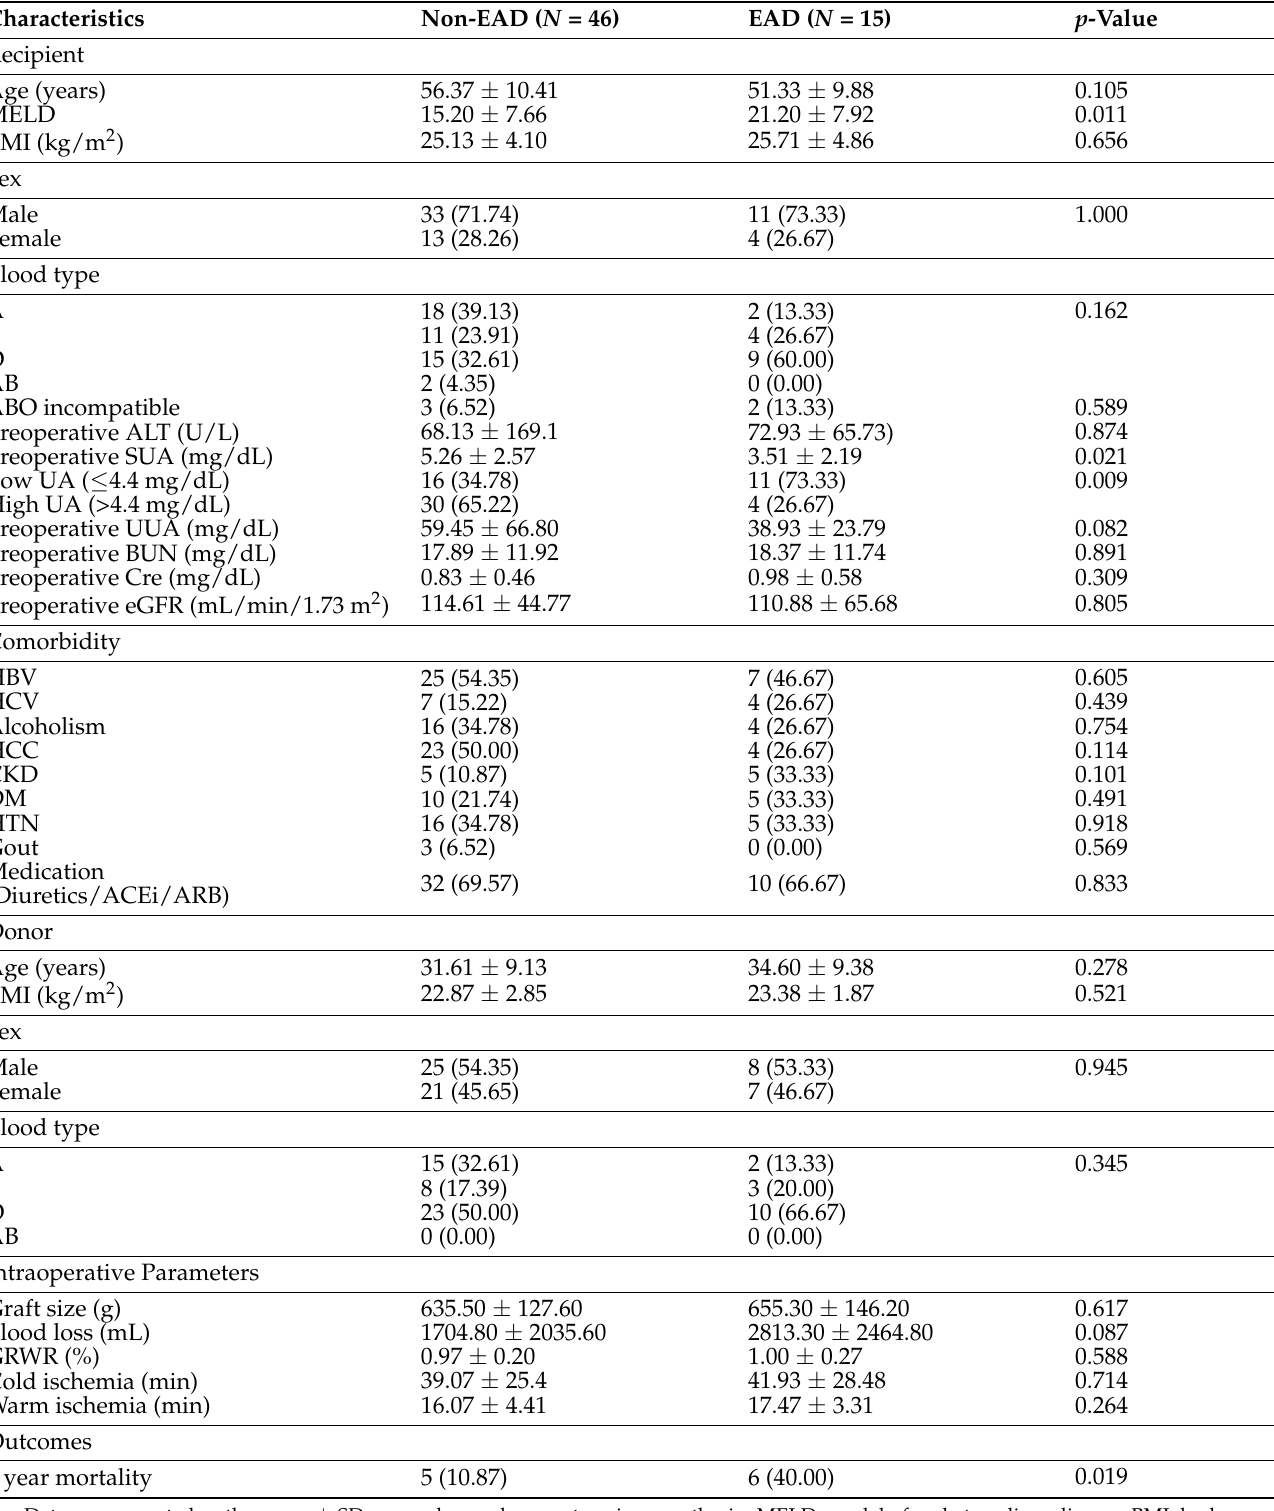
Table 2. A comparison of non-EAD and EAD